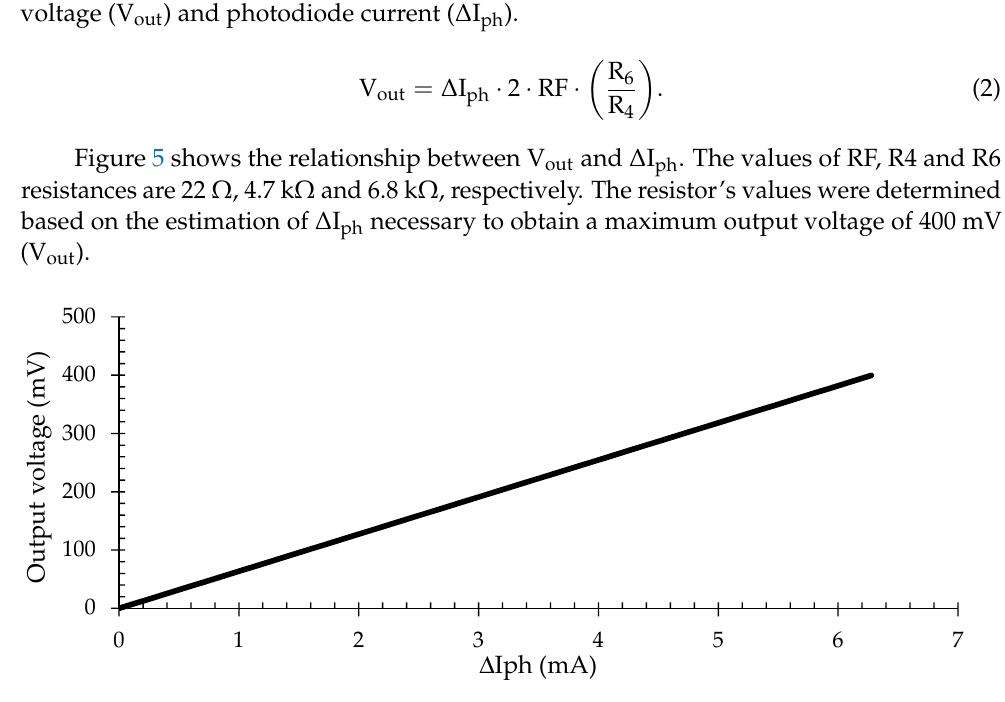
Figure 5. Output voltage (mV) behavior for the signal conditioning circuit.